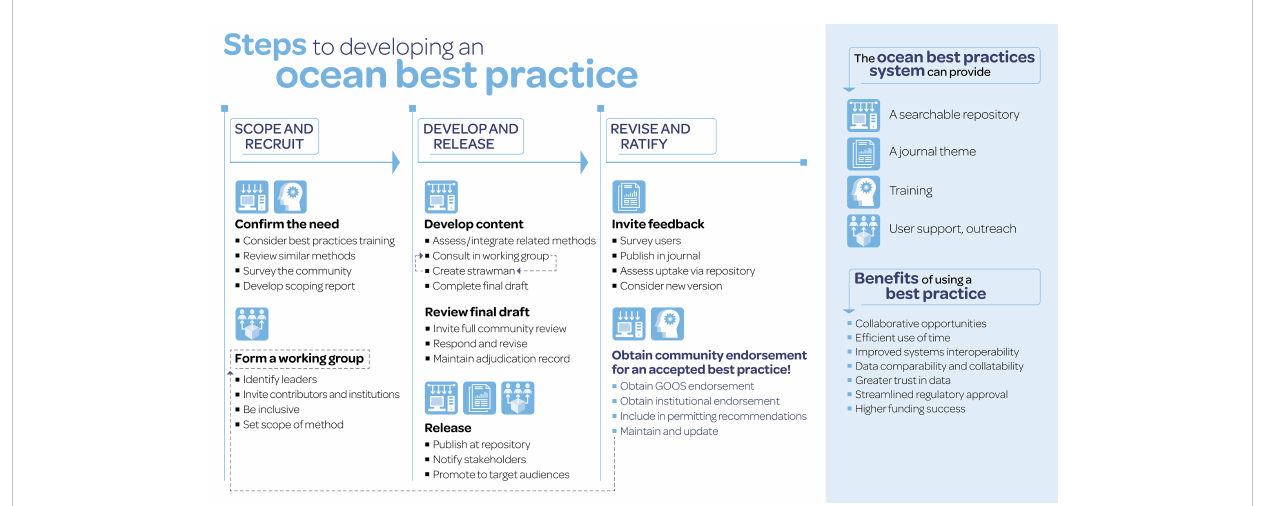
FIGURE 2 The three phases and associated steps required to develop an ocean best practice. Each step is linked to icons showing the relevant part of the Ocean Best Practices System that provide